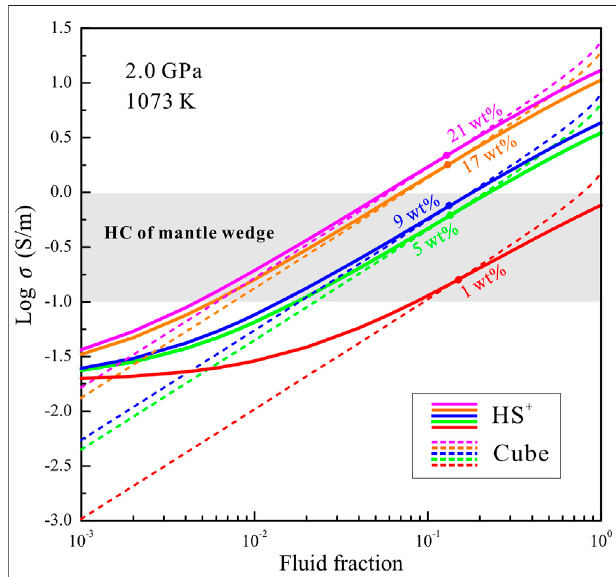
FIGURE 8 | Electrical conductivities of the Ol – NaCl – H 2 O systems with constant salinity (1, 5, 9, 17, and 21 wt%) and various fl uid fractions (0.1 – 100 vol%) based on the HS + and cube models at 2.0 GPa and 1073 K. The electrical-conductivity region (0.1 – 1 S/m) of the high-conductivity layers in the mantle wedges of subduction zones is indicated by a gray rectangle (Yamaguchi et al., 2009; Burd et al., 2013; McGary et al., 2014; Hata et al., 2017). The solid and dashed color curves represent the conductivities from the HS + and cube models,